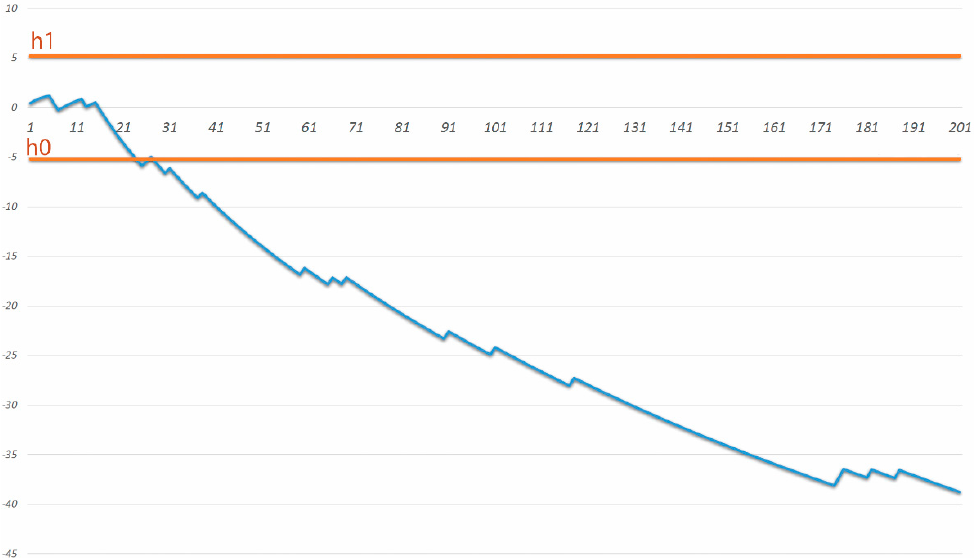
Figure 2. Risk-adjusted sequential probability ratio test (RA-SPRT) chart for complications according to the Clavien–Dindo classification. The x-axis represents the operation number. The y-axis represents a cumulative log-likelihood ratio value. CCI complication rate and length of stay (LOS) were plotted in a graph using the moving- average (MA) method (Figure 3.).